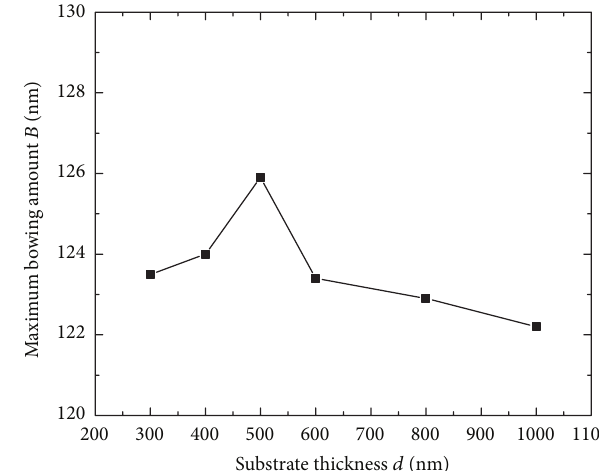
Figure 5: The linear relationship between the bowing amount and the square of sapphire diameter.